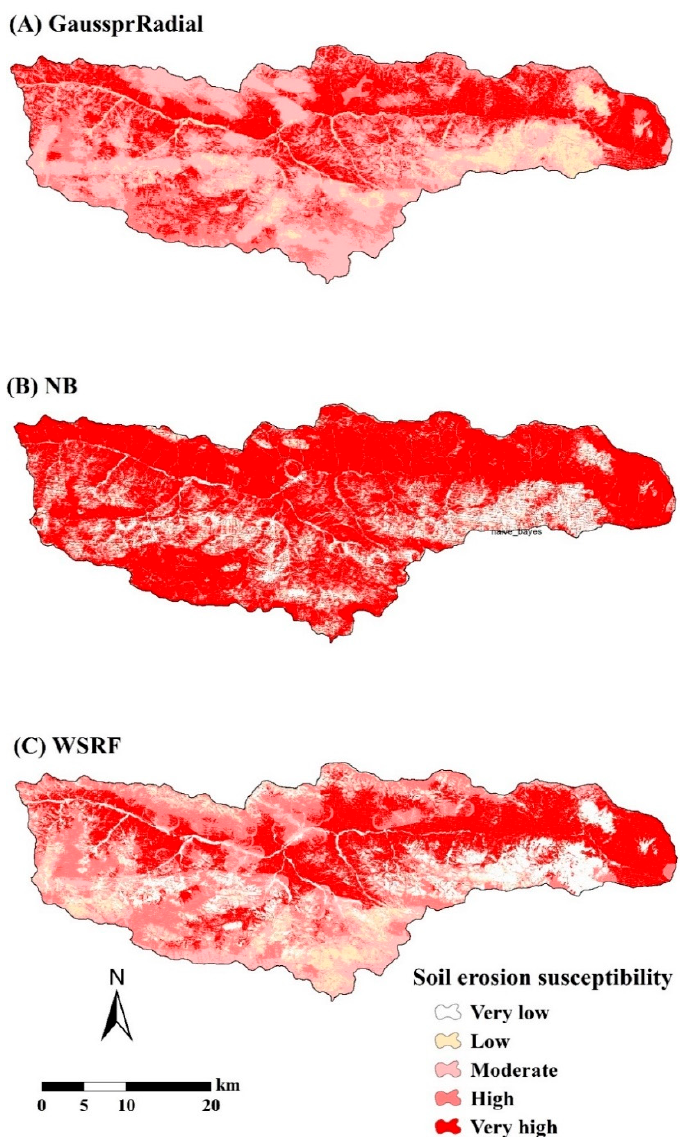
Figure 8. Spatial prediction of water erosion using various methods: ( A ) Gaussprradial, ( B ) NB, and ( C ) WSRF.